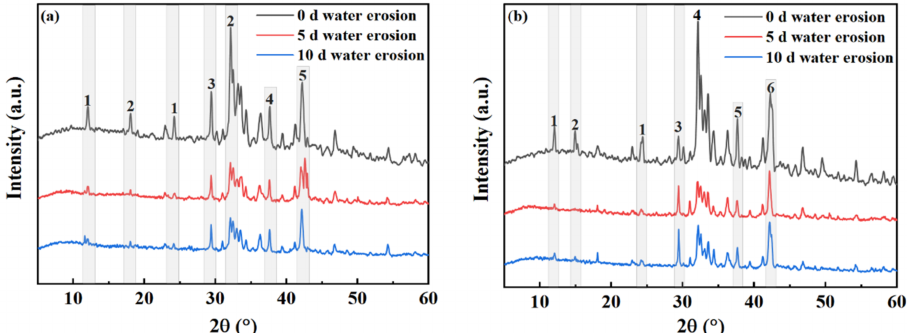
Figure 14. Mineral composition changes of untreated and treated steel slag under different water